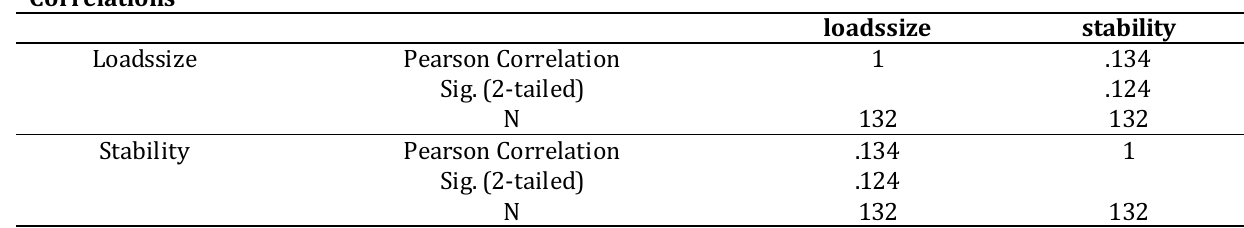
Table 4: Correlations between ship's stability and load for loading below load line